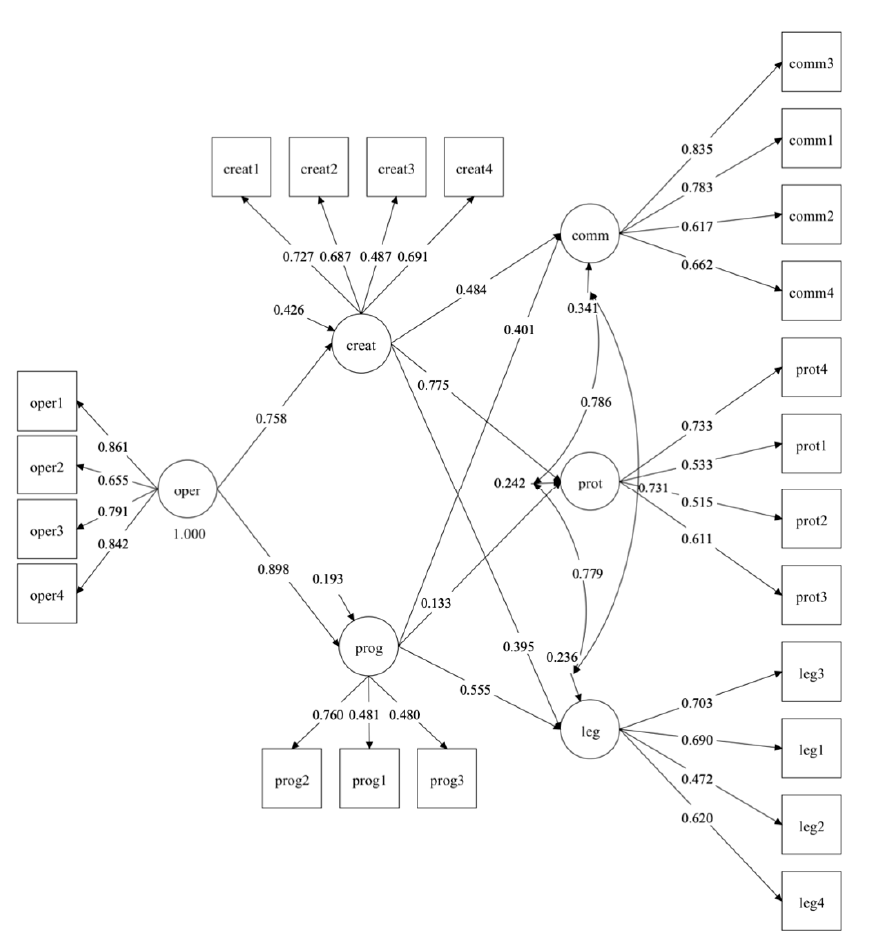
Figure 4. SEM model for predicting digital knowledge and skills dimensions that are developed in social settings (COMM—communicating in the digital world, PROT—protecting oneself and others in the digital world, LEG—legal behaviour in the digital world) based on knowledge and skills developed in individual settings (CREAT—creating digital materials, PROG—programming digital content, OPER—performing operations with digital tools).